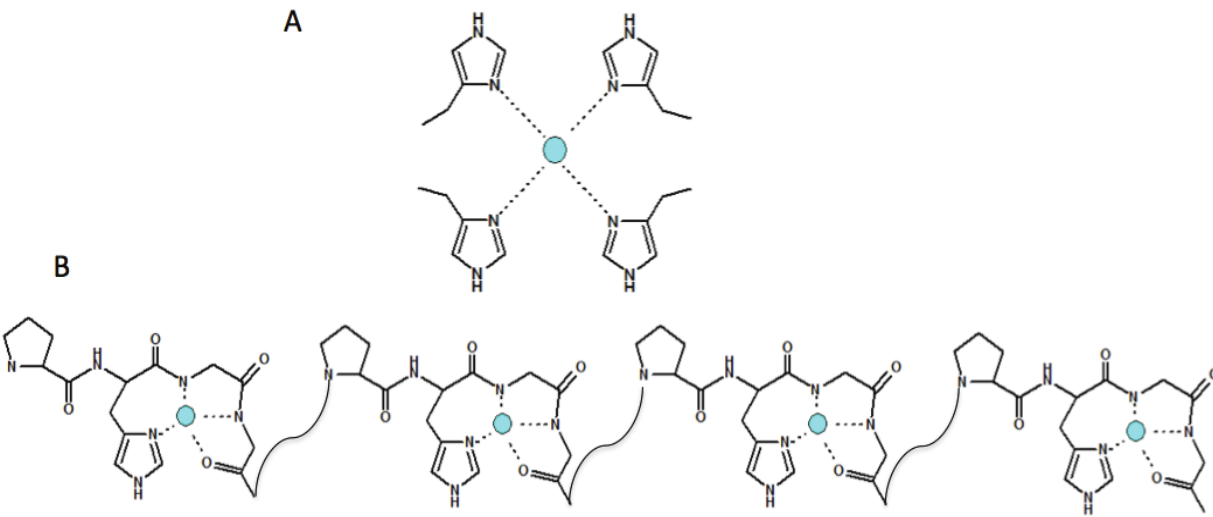
Figure 3. Sketches of different copper coordination modes with the mammal